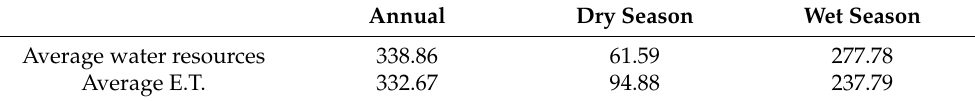
Table 3. Average water resources and E.T. (10 8 m 3 ) in the Hanjiang River Basin from 1970 to 2020.